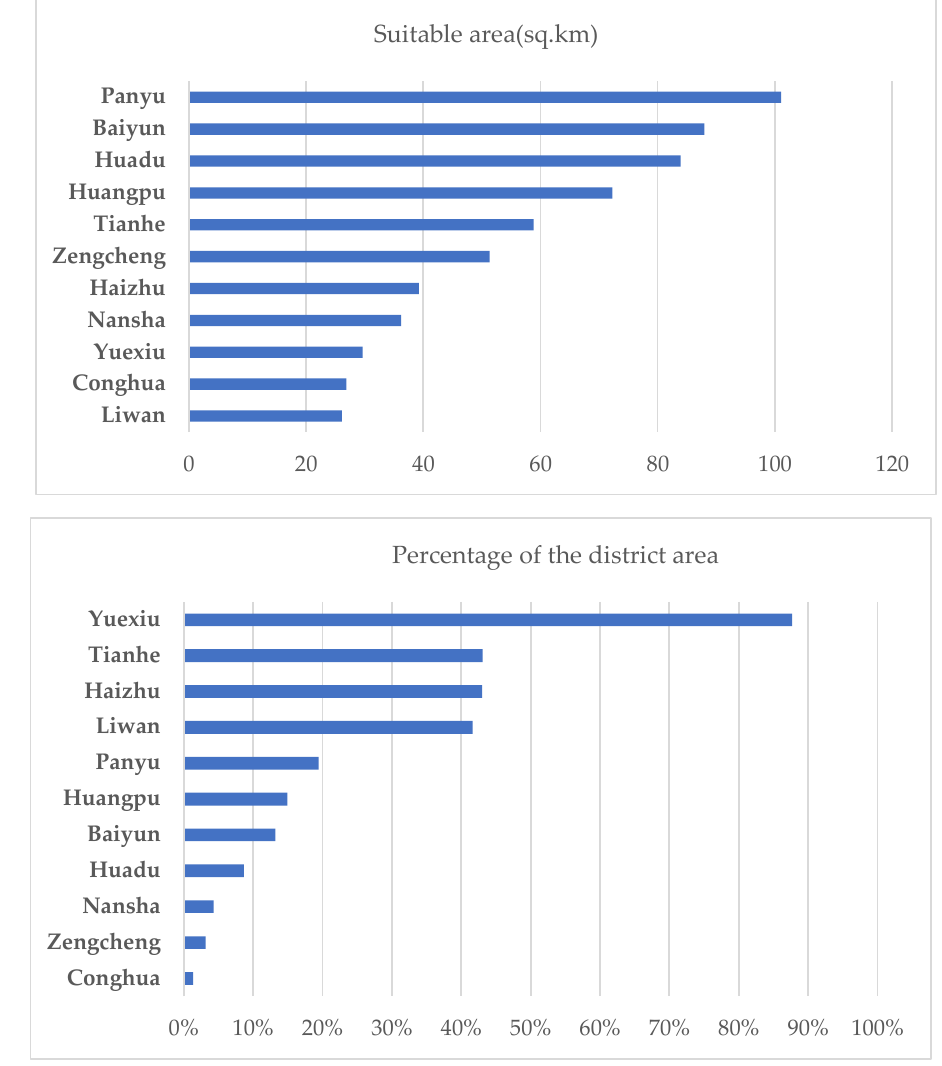
Figure 6. Summary of the suitable areas for PPLs.